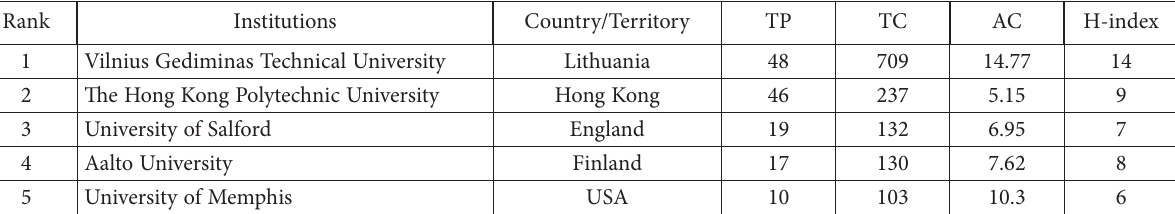
Table 3. The most productive and influential institutions in the